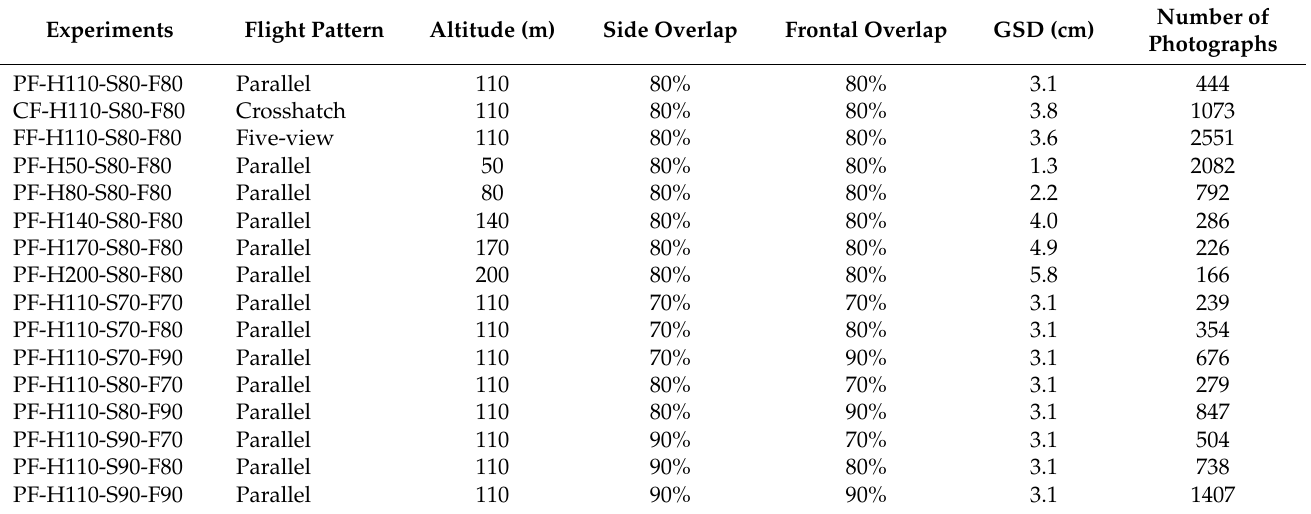
Table 2. UAV flight experiments with different photogrammetric